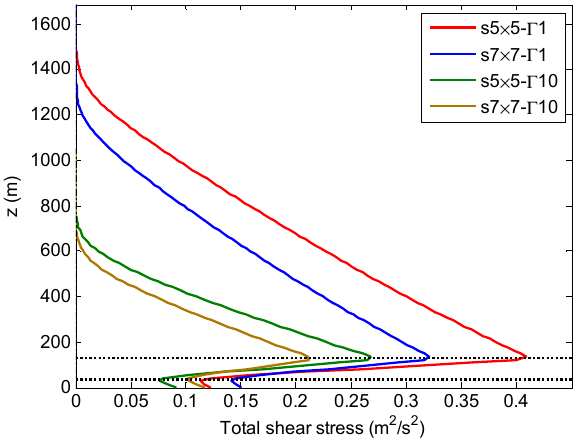
Figure 7. Vertical profile of total shear stress (cid:3436)(cid:3495) τ (cid:2934)(cid:2936)(cid:2870) + τ (cid:2935)(cid:2936)(cid:2870) (cid:3440) for two different wind-turbine spacings, and two different values of Γ through very large wind